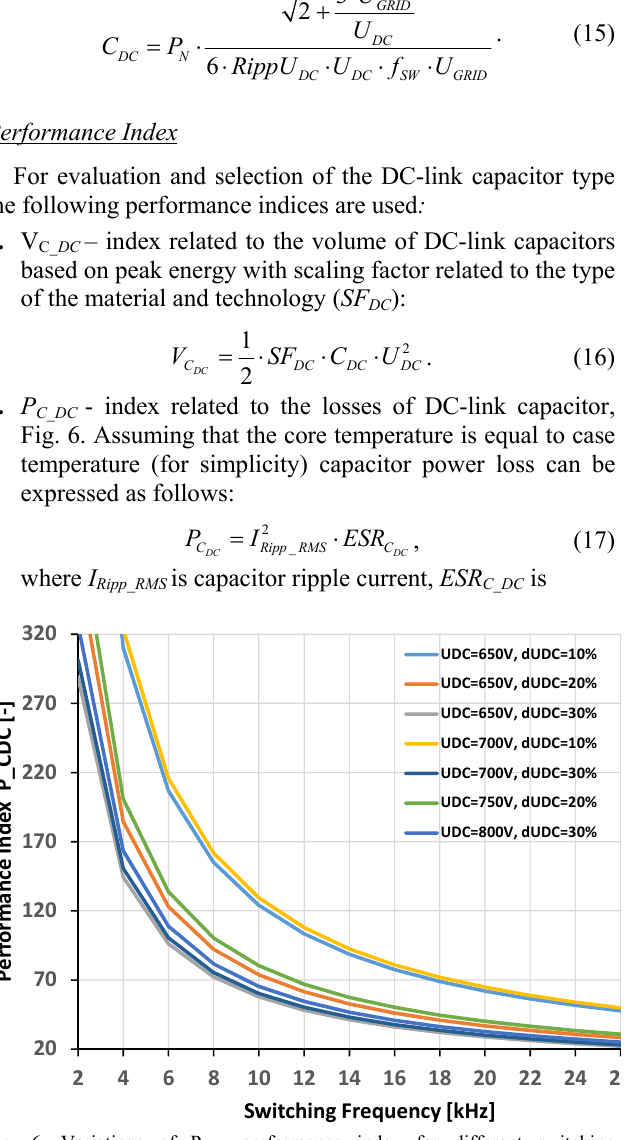
Fig. 6. Variations of P CDC performance index for different switching frequencies with changes of U DC and RippU DC parameters. Analysis performed for 14 kVA